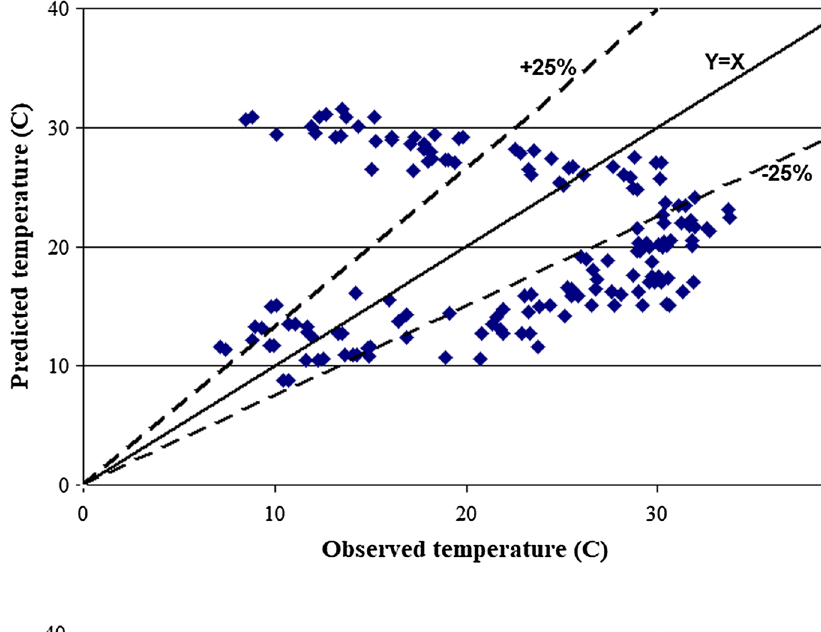
Fig. 3 Predicted temperature using GEP against the observed